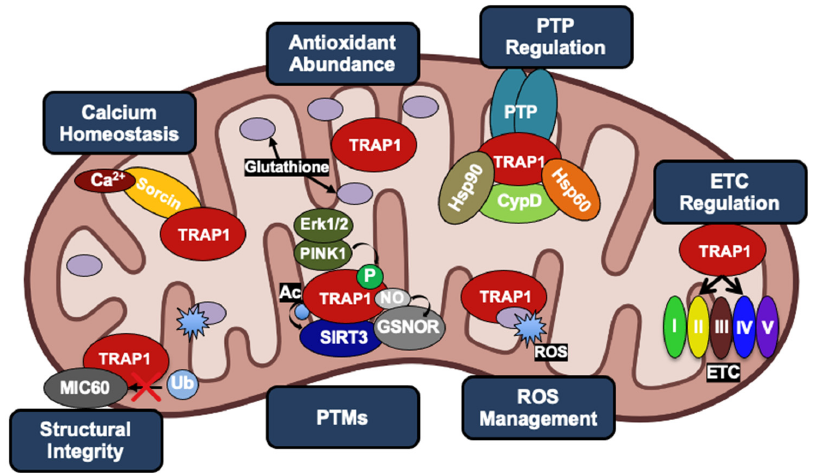
Figure 6. The multiple roles of TRAP1 in cancer cell mitochondria, revolving around evasion of apoptosis and metabolic reprogramming. TRAP1 acts as a chaperone for the Ca 2+ binding protein Sorcin as well as Complexes II and IV of the ETC. Increased TRAP1 levels are associated with calcium tolerance, increased levels of the antioxidant glutathione, reduced levels of ROS, reduced levels of MIC60 ubiquitination, and in many cases, a shift towards the Warburg effect. TRAP1, along with Hsp90 and Hsp60, can form a complex with CypD to prevent opening of the PTP. TRAP1 is post-translationally modified by PINK1, Erk1/2, GSNOR, and SIRT3.